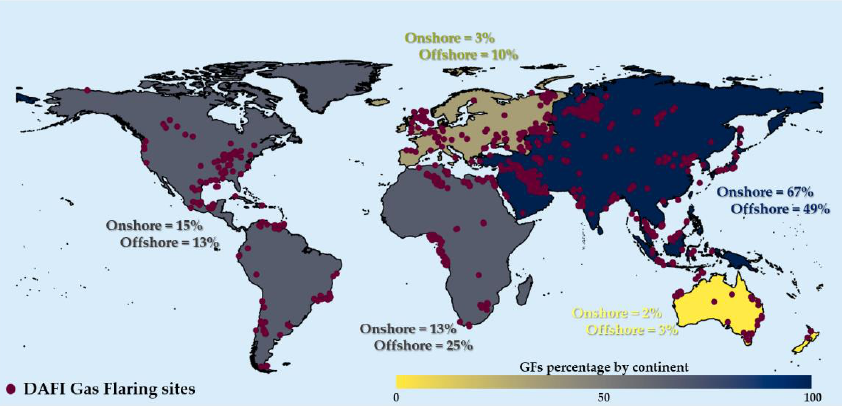
Figure 3. Distribution of GF sites detected by DAFI (purple dots) among the five continents. The onshore and offshore percentages computed for each continent is also stated.